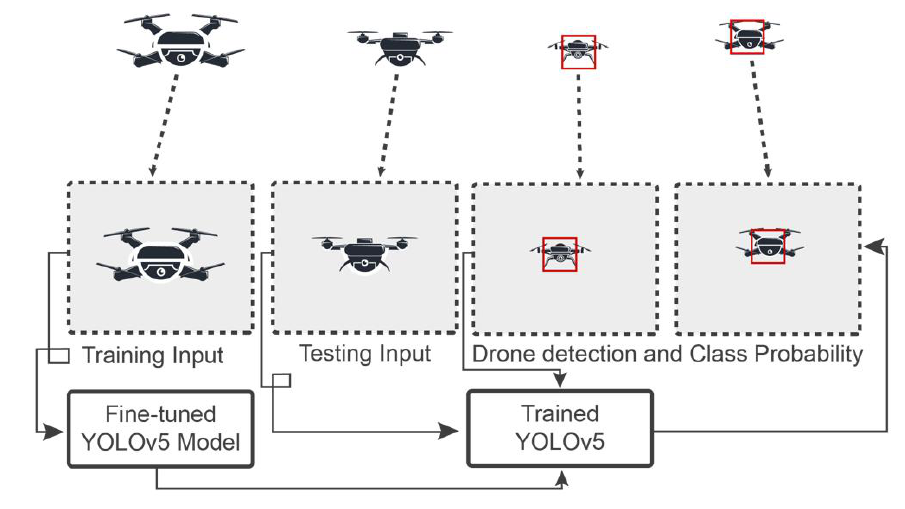
Figure 6. Flowchart of the conducted